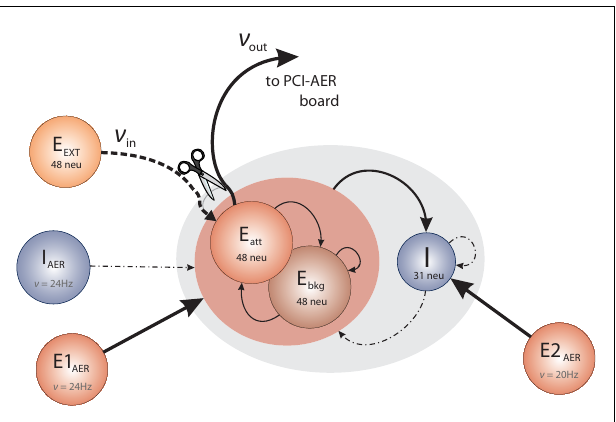
FIGURE 3 | Modified network architecture to measure the effective response function of population E att . Recurrent connections within E att are severed and their input replaced by input from external population E ext . In all other respects, the network remains unchanged.The effective response function is ν out = (cid:7) ( ν in